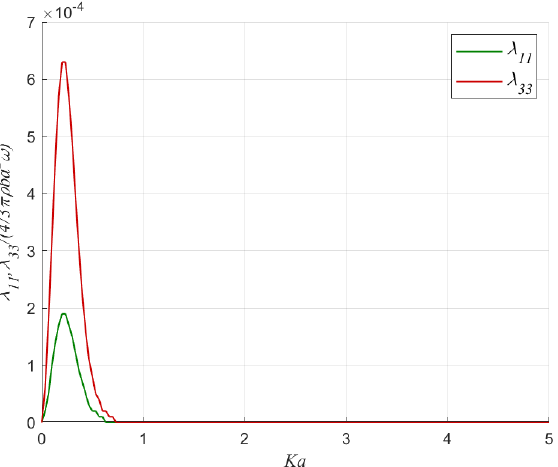
Figure 11. Normalized damping coefficient for a / b = 1.1, f = 9 a and h = 10 a : surge and heave mo- tion.